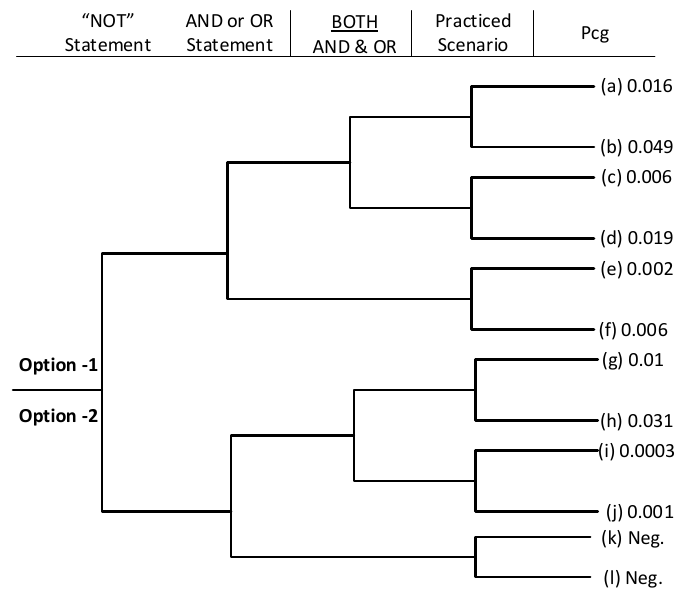
Figure 9. Pcg in the MCBDT.